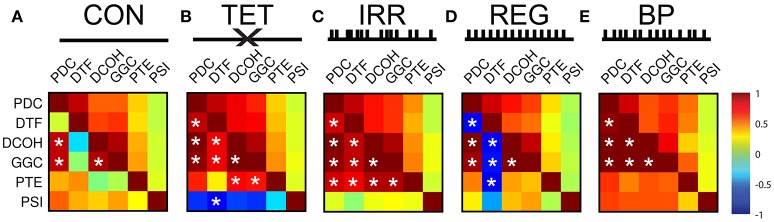
Correlation matrices for frequency- and time-representation similarities across different experimental conditions and different DCEs. For each matrix, the upper half represents correlation coefficients in the time domain (which are all statistically significant at p < 0.001). The lower half of the matrix represents correlation coefficients in the frequency domain, and statistically significant correlations after Bonferroni correction are marked with white asterisks (p < 0.05, Bonferroni corrected). (A) In CON, time-domain correlations are better among the MVAR-based methods, and there is no PSI correlation to other estimators. DTF is poorly correlated with other in the frequency domain. (B) In TET, there is increase time- and frequency-domain correspondence. PSI shares negative correlations with all other estimators. (C) In IRR, similar pattern of time- and frequency-domain correlations, with PSI showing little correlation with other estimators. (D) In REG, DTF frequency-domain representation anti-correlates with all other estimators. PSI frequency-domain correspondence is highly variable in REG. (E) In BP, highest frequency-domain correlations are seen, while PSI remains to be uncoupled in the time domain. CON, control; TET, tetracaine; IRR, irregular; REG, regular at 7.7 Hz; BP, by-pass; DCE, directed connectivity estimate; MVAR, multivariate auto-regressive modeling; DTF, directed transfer function; PSI, phase slope index.